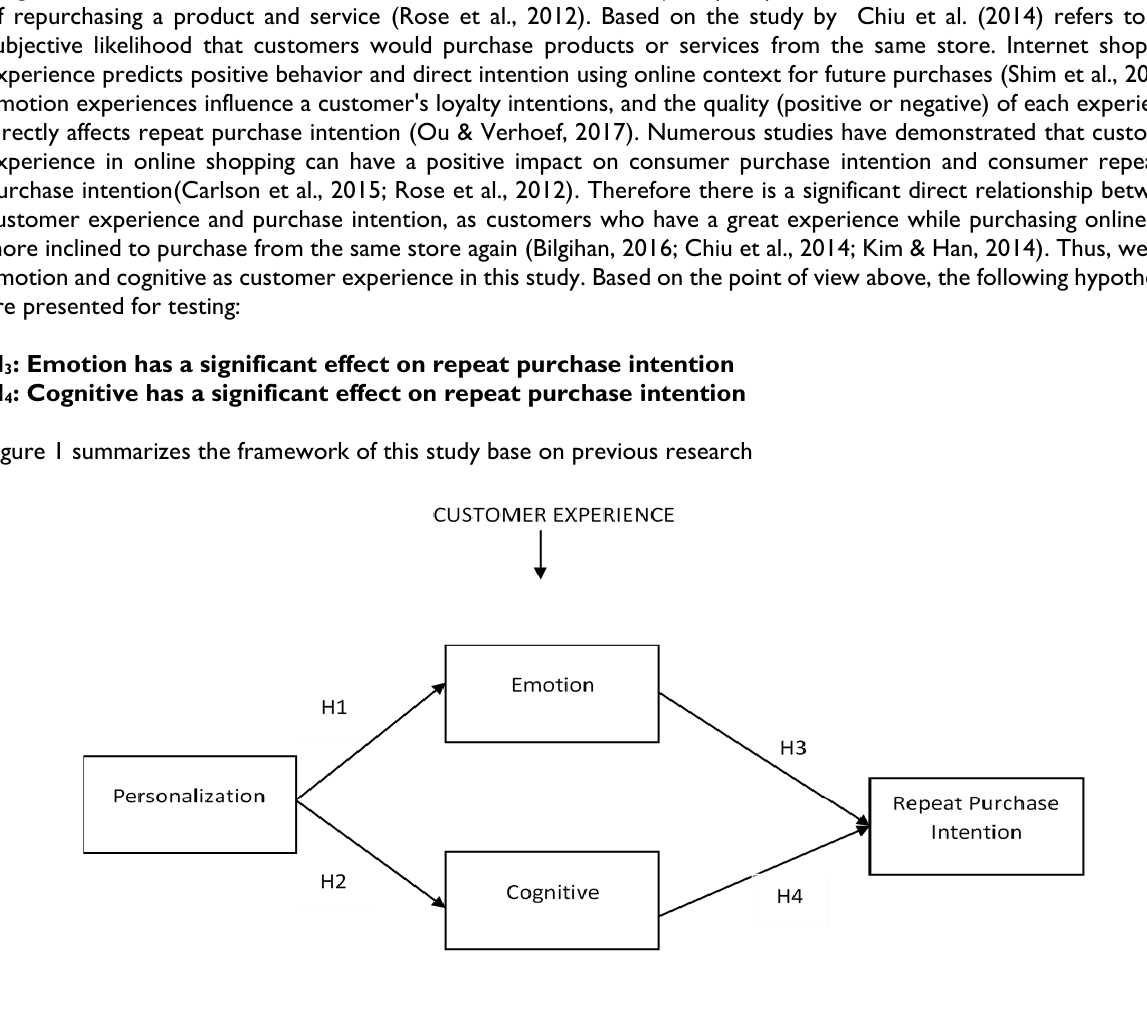
Figure 1. Conceptual